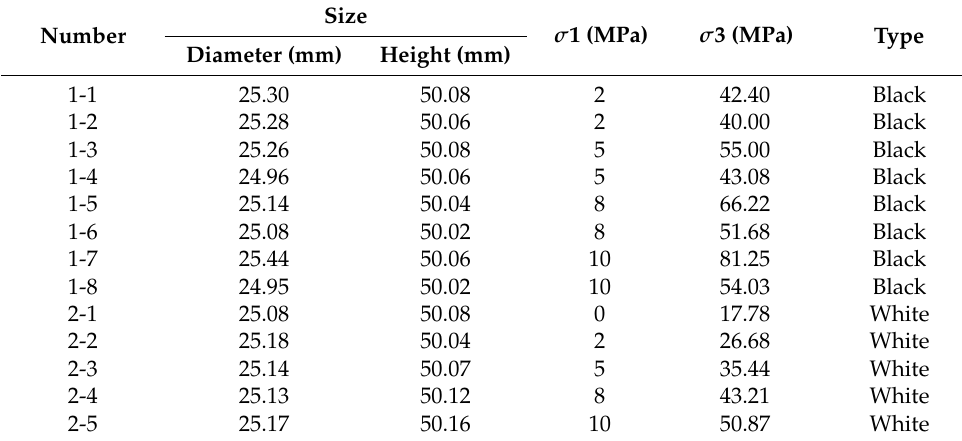
Figure 10. Stress strain curves of ( a ) black sample and ( b ) white sample. Table 3. Data of triaxial compression test.